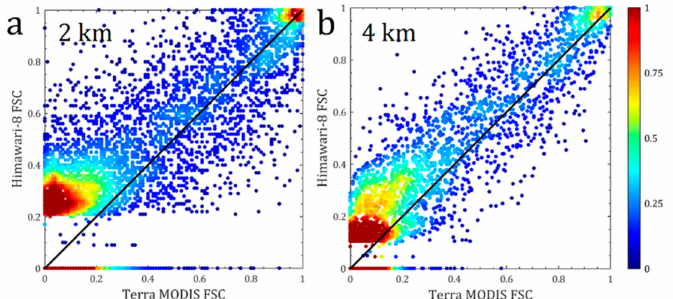
Figure 12. The scatter plot of Himawari–8 AHI fractional snow cover with MOD10A1 at the spatial scale of 2 km with 15,000 points ( a ) and of 4 km with 3750 points ( b ).